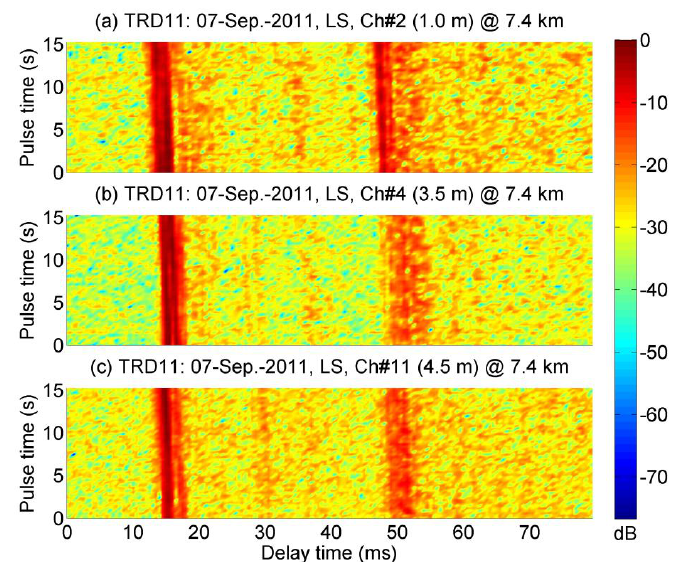
Figure 4. Channel response at different depths. ( a ) 1 m; ( b ) 3.5 m; ( c ) 4.5